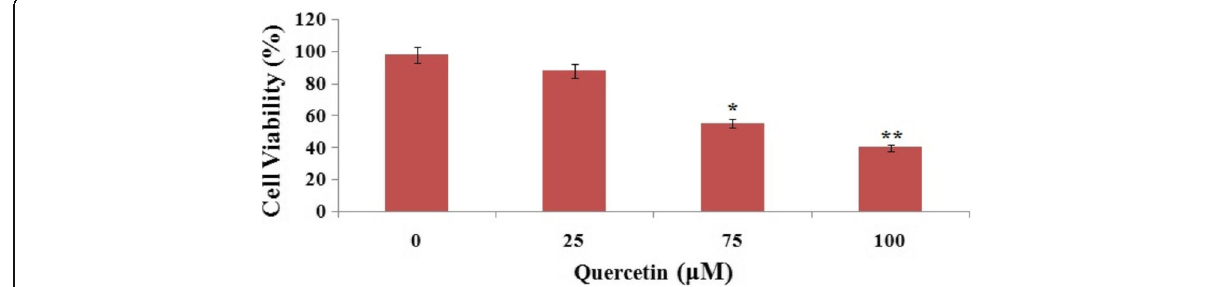
Fig. 1 Study of various concentration of Quercetin on the viability of Y79 human retinoblastoma cells in vitro. Cell viability was evaluated at various concentrations of Quercetin (0-100 μ M) for 24 h. All the data are means ± SD ( n = 3) and are represented as percentage of control cells. * P < 0.05,** P < 0.01 compared to